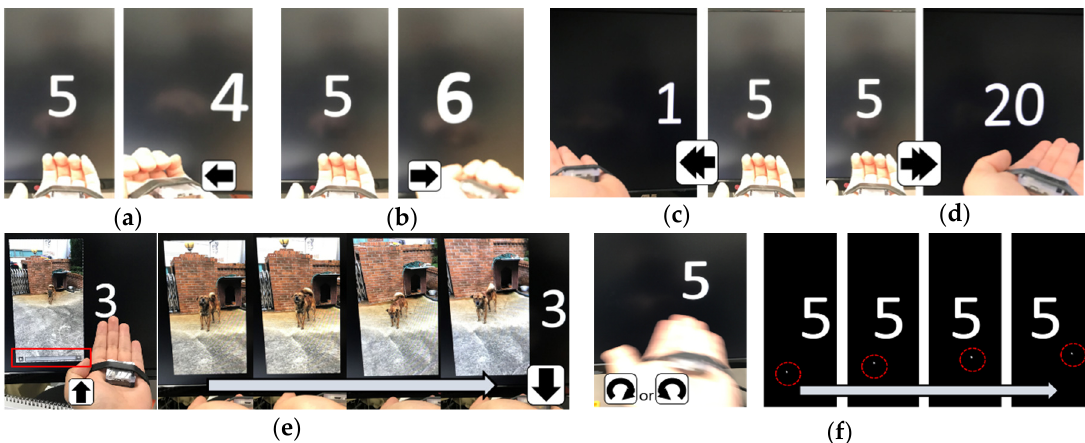
Figure 6. Sequence of experiments, ( a ) going to the previous slide, ( b ) going to the next slide, ( c ) jumping to the first slide, ( d ) jumping to the last slide, numbered 20, ( e ) selecting and executing a video clip, ( f ) activating the focus mode and moving the mouse cursor as a pointer. Table 5. Result of the presentation software (participant = 5; trials = 50).